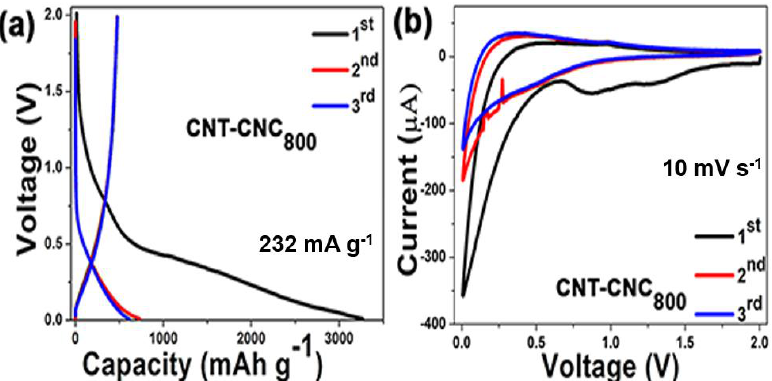
Figure 7. Electrochemical performance data of the composite electrodes. ( a ) Initial voltage profiles